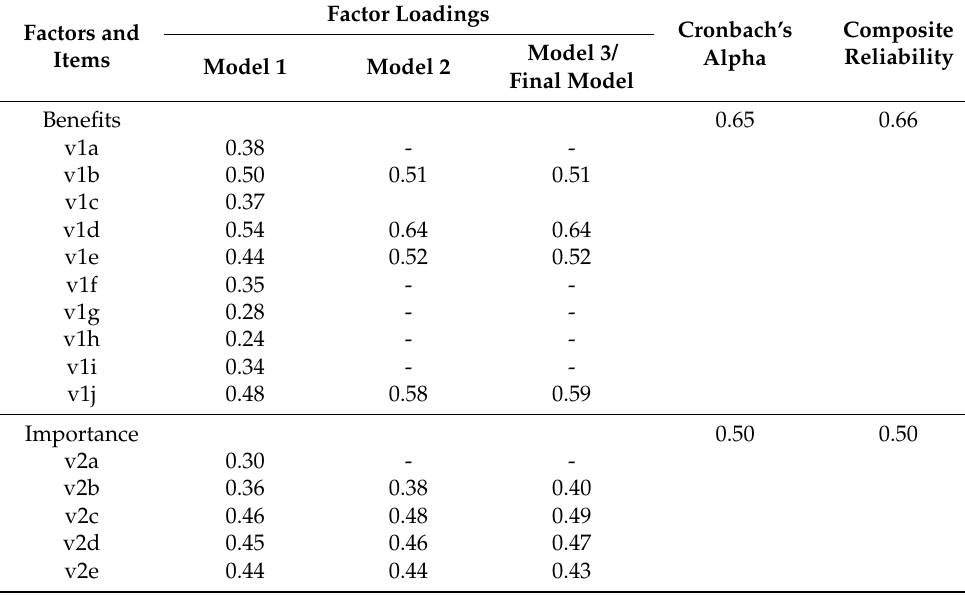
Table 2. Standardized factor loadings for Model 1, Model 2 and Model 3 of the APAS-C. Factors